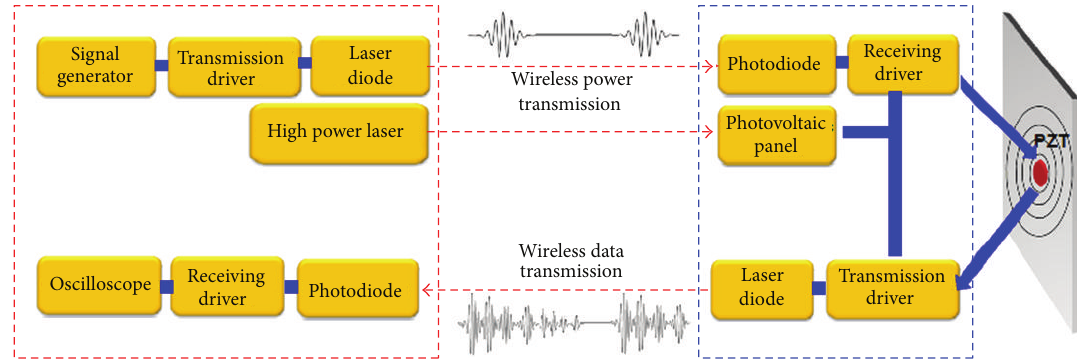
Figure 37: A schematic for optics based wireless guided wave generation and sensing